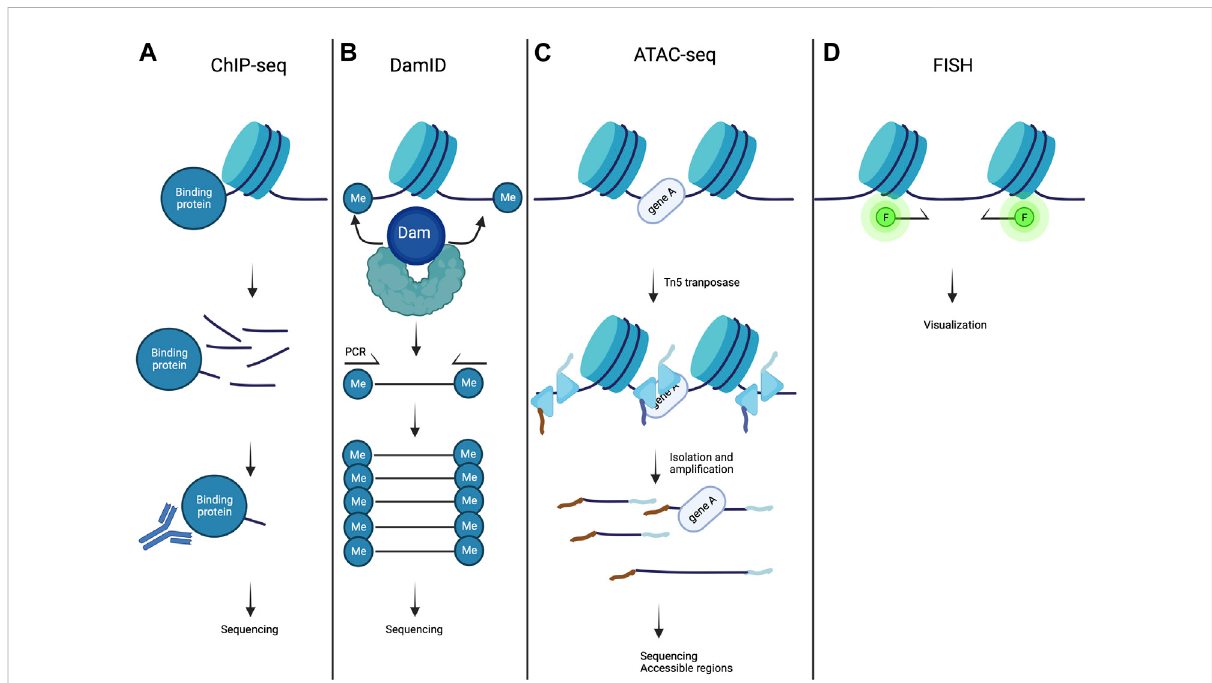
FIGURE 4 Methods to study chromatin organization. (A) In ChIP-seq experiments, chromatin is fragmented and magnetic beads conjugated to antibody speci fi c to the target protein are used to precipitate chromatin fragments bound to the protein of interest. This is then followed by sequencing and mapped ontothegenomeassembly. (B) InDamID,afusionproteiniscreatedconsistingofdammethyltransferase andaproteinofinterest, resulting inlocalmethylationofadeninesinGATCsequencesonthechromatin.Thegenomicmethylationpatterncanbemapped usingsequencing. (C) ATAC- seq is a methodology used for identifying open chromatin regions. Chromatin is incubated with Tn5 transposase to simultaneously fragment and index the exposed DNA fragments. This is then followed by sequencing. (D) In FISH methods, DNA loci of interest are labeled